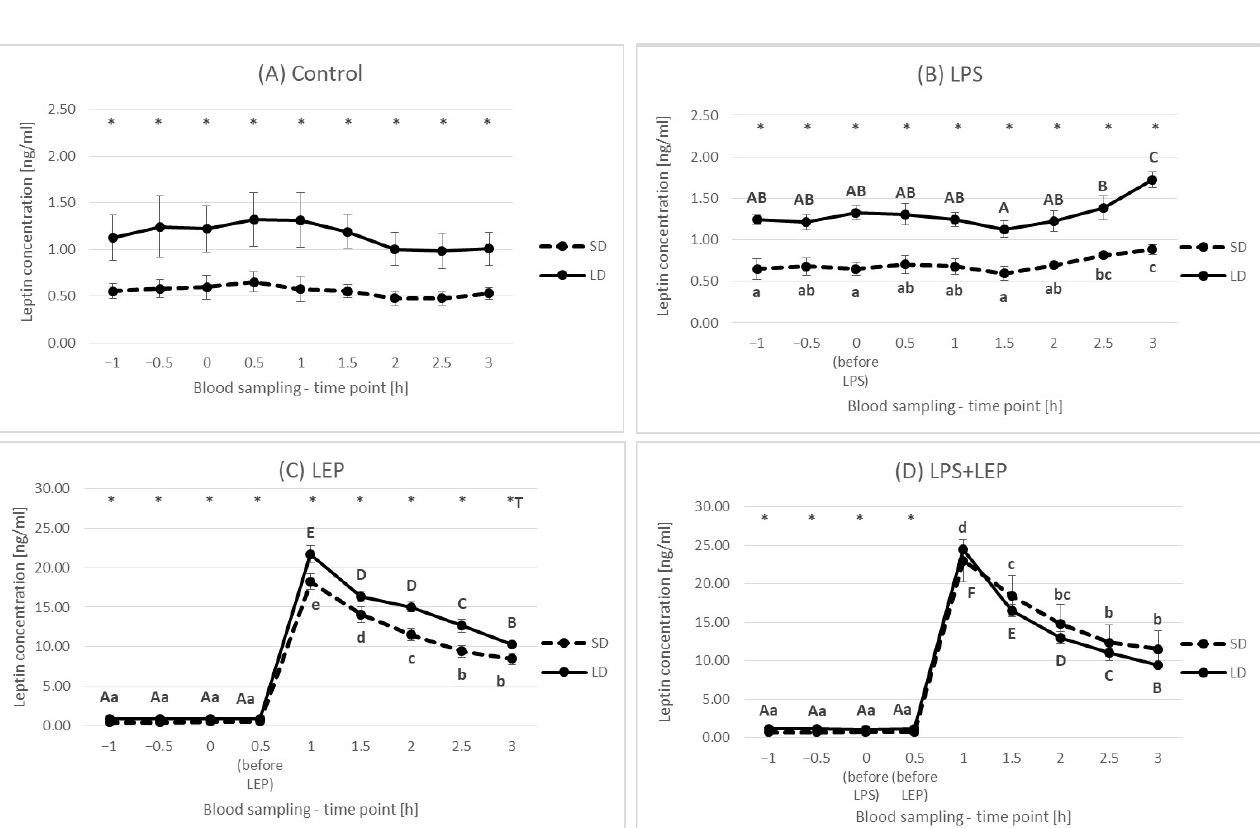
Figure 2. Plasma leptin concentration for each experimental group separately (Control ( A ), LPS ( B ), LEP ( C ) and LPS + LEP ( D )) at each examined time point and season; *—indicates the statistically significant difference between the short-day (SD) and long-day (LD) photoperiod at each time point according to Student’s t -test ( p ≤ 0.05) ( n = 6); *T—indicates the tendency in a difference between photoperiods at each time point according to Student’s t -test (0.1 > p > 0.05); a–e and A–F—indicate the statistically significant difference between time points for the SD and LD seasons, respectively, according to a repeated measured analysis of variance (ANOVA) followed by Fisher’s post-hoc test ( p ≤ 0.05) ( n = 6). Groups: control—saline injection, LPS—lipopolysaccharide injection at a dose of 400 ng/kg of body mass after a 0 h time point, LEP—leptin injected at a dose of 20 μ g/kg of body mass at a 0.5 h time point, LPS + LEP—LPS and LEP injections at the same doses and time points as those in the LPS and LEP groups.